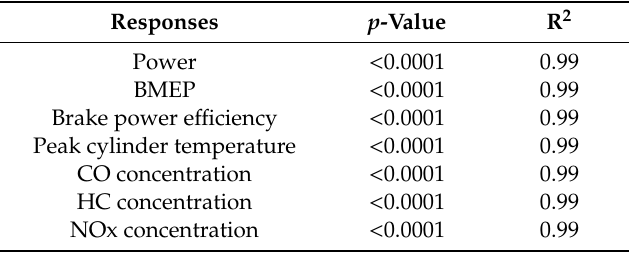
Table 5. The fitness goodness for each response equation.